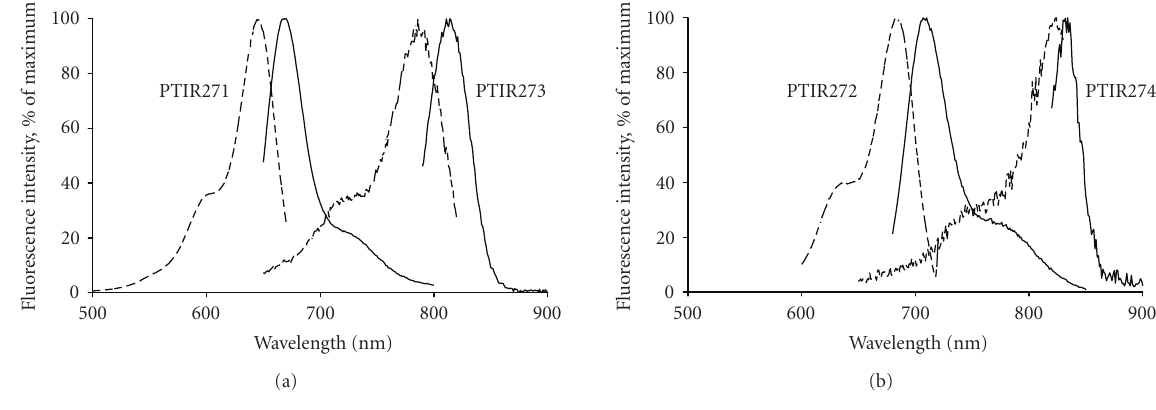
Figure 1: Normalized excitation (dashed lines) and emission (solid lines) spectra of novel far-red and near-IR fluorescence probes. Spec- tra of 250nM dye in ethanol were acquired with a Photon Technology International spectrofluorometer (R928 PMT; slit width 4 nm) and normalized-to-peak intensity. Peak excitation and emission wavelengths (nm) were PTIR271–644/670; PTIR272–683/707; PTIR273– 786/814; PTIR274–824/834. Small Stokes’ shift and low fluorescence intensity made it di ffi cult to get a complete excitation scan of PTIR274.